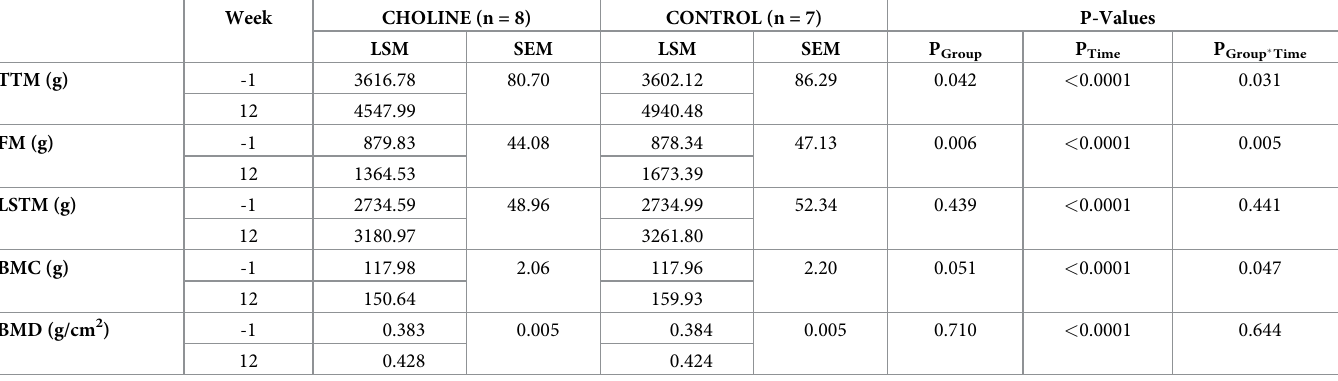
Table 3. Dual-energy X-ray absorptiometry measurements of post-gonadectomy kittens supplemented with additional choline at 300 mg/kg BW 0.75 (CHOLINE, n = 8) over 12 weeks compared to a group fed only the base diet (CONTROL, n = 7).